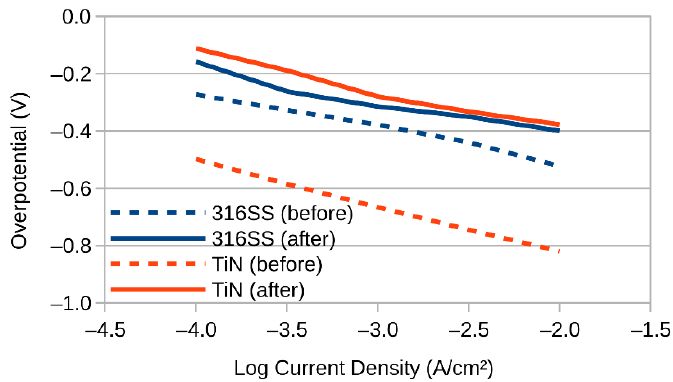
Figure 5. Variation of cell voltage over 2000 cycles of Ageing Protocol B.